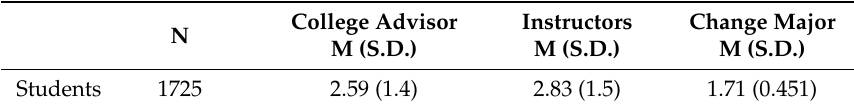
Table 6. Means, Standard Deviations, and Numbers for the college advisor positive factor, instructors’ positive factor and major